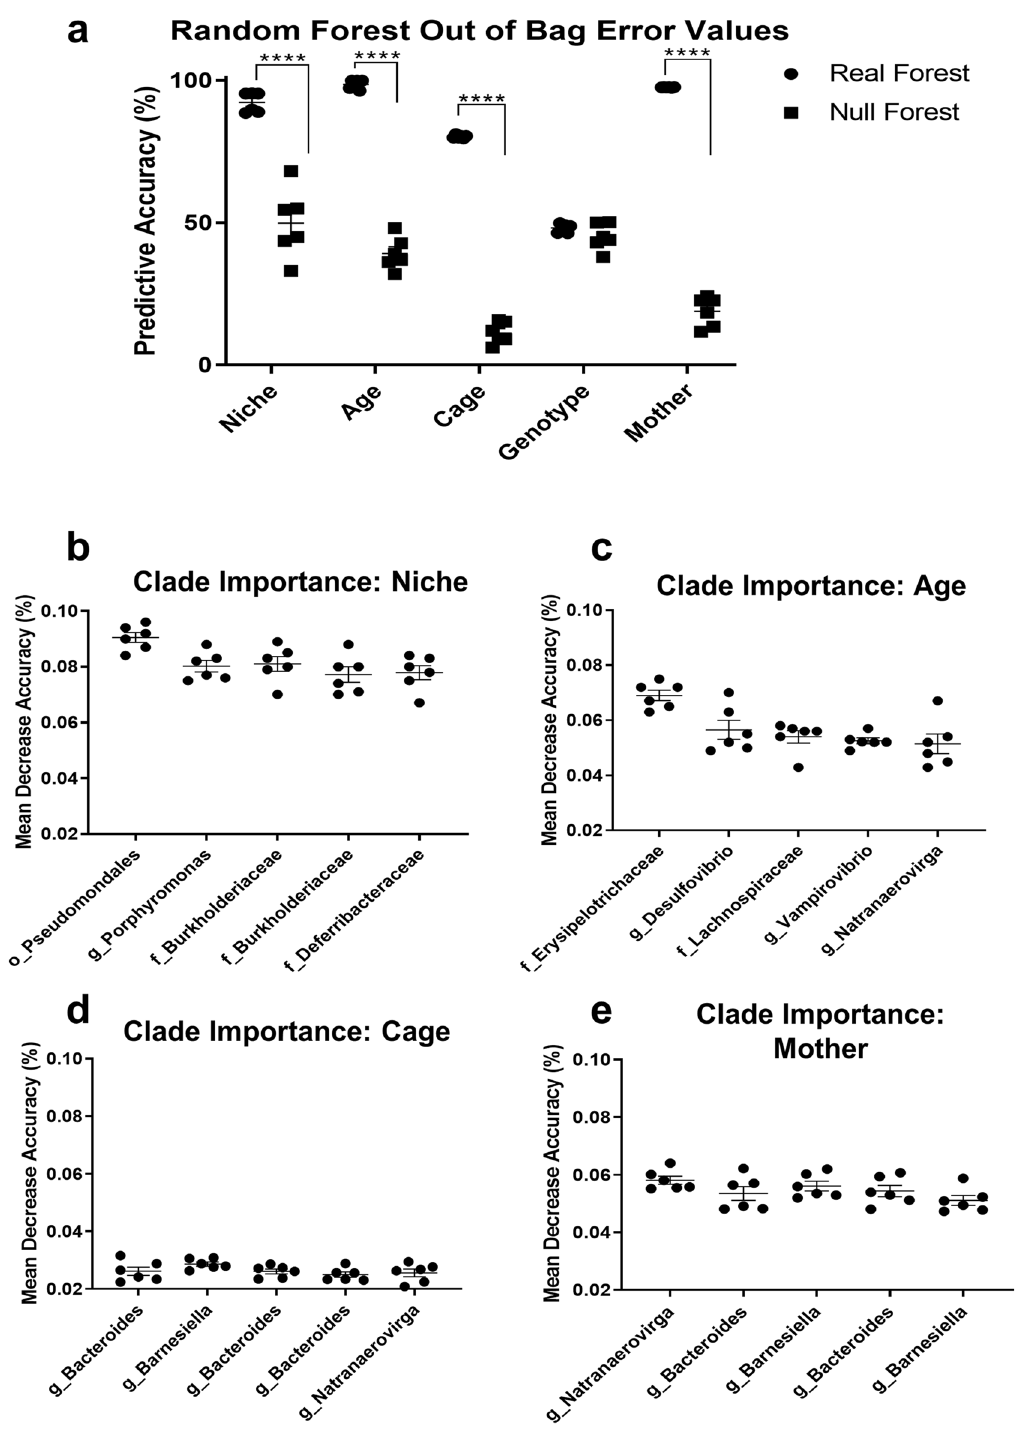
Figure 3. Random forest model identifies strong associations between the microbiota, niche, age and cage. The predictive accuracy of the random forest model at taking a sample and discriminating between the different treatment groups is shown ( a ). The five most important nodes associated with microbial niche ( b ), host age ( c ), social group (cage) ( d ) and mother ( e ), are named based on the finest scale taxon containing the closest BLAST hits of all sequences in the clade. Taxa are prefixed with their taxonomic level: order (o_), family (f_) and genus (g_). Bars represent means and standard errors. Asterisks represent significance determined using Two Way ANOVA-Sidak’s post hoc: P < 0.00001 (****). Similar plots for further validation control analyses are shown in Supplementary Figure S3 and S4. n = 6 technical replicates. Figure produced in GraphPad Prism